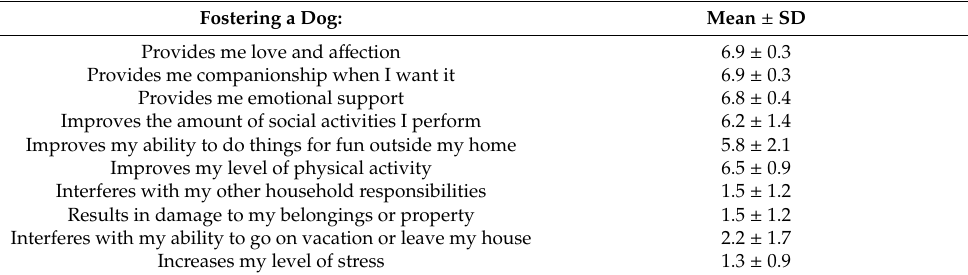
Table 7. Modified Dog Owner Specific Quality of Life (DOSQOL) questionnaire responses (n =